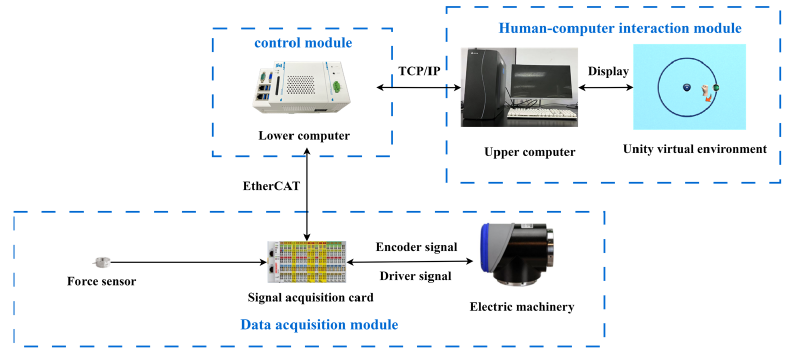
Figure 2. Diagram of the control system hardware.